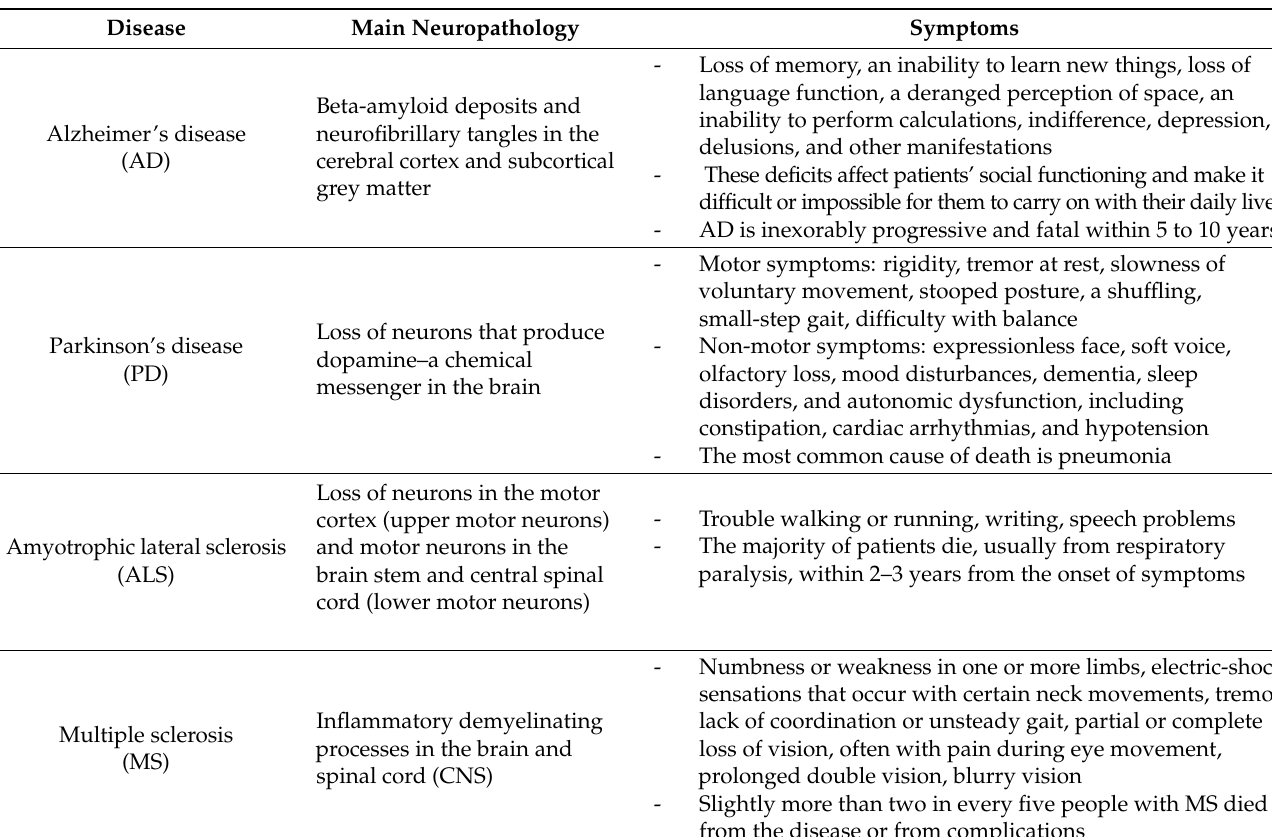
Table 1. Overview of common neurodegenerative diseases. Based on data from the public domains [34,35]. Disease Main